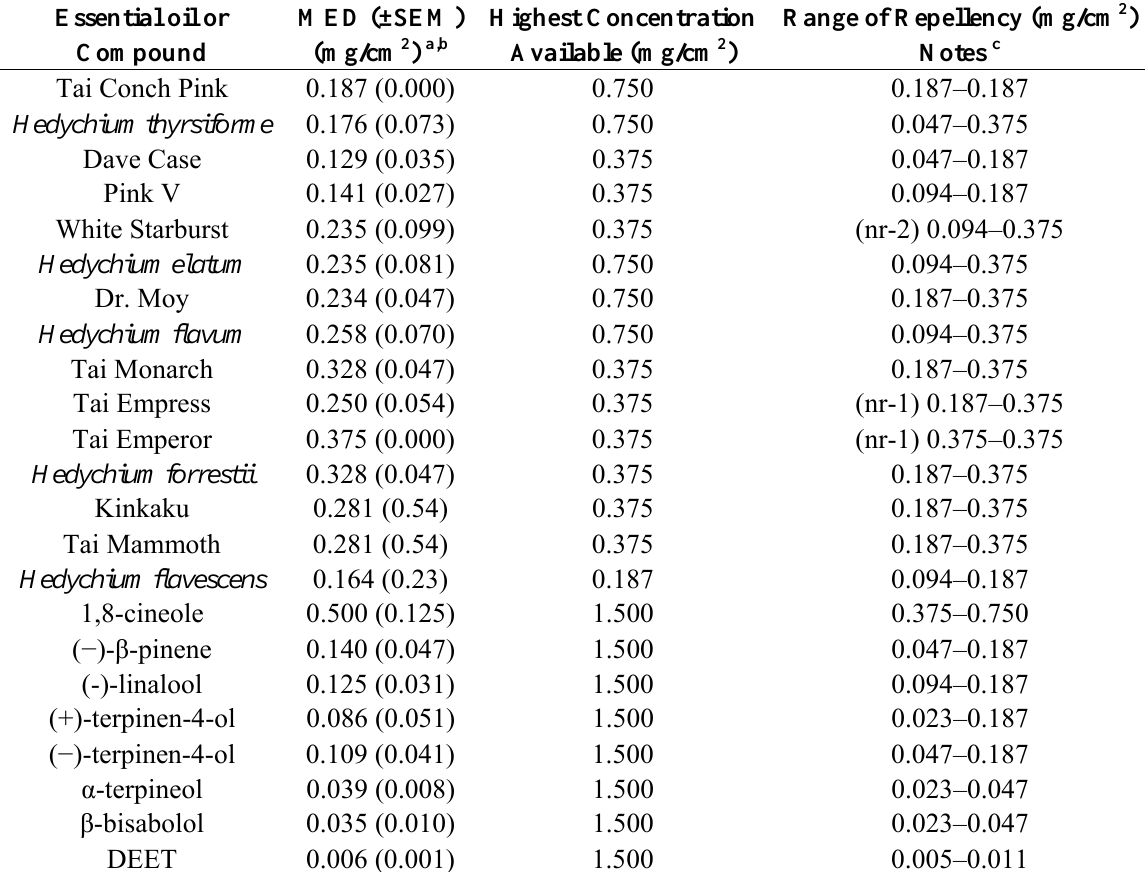
Table 3. Minimum effective dosage (MED) of oils and individual constituents tested against the yellow fever mosquito, Aedes aegypti (L.), to 17 essential oil extracts and one commercial repellent (DEET). All oils and compounds were evaluated by four